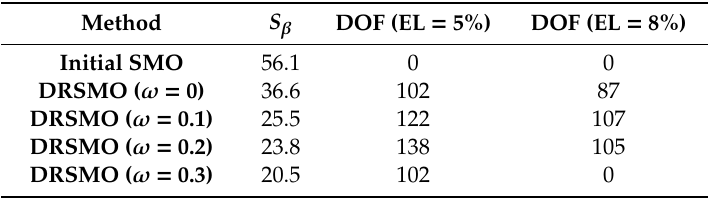
Table 2. The target 1 optimized values of S β , depth of focus (DOF) (nm) corresponding to exposure latitude (El) equal to 5% and 8% for conventional SMO, and DRSMO with ω = 0, ω = 0.1, ω = 0.2, and ω = 0.3,